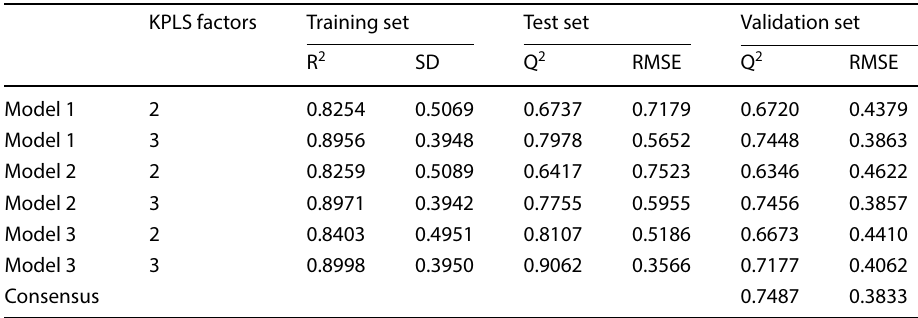
Table 3 QSAR Models with respective statistical values. The final is a consensus global model for sst agonists 4